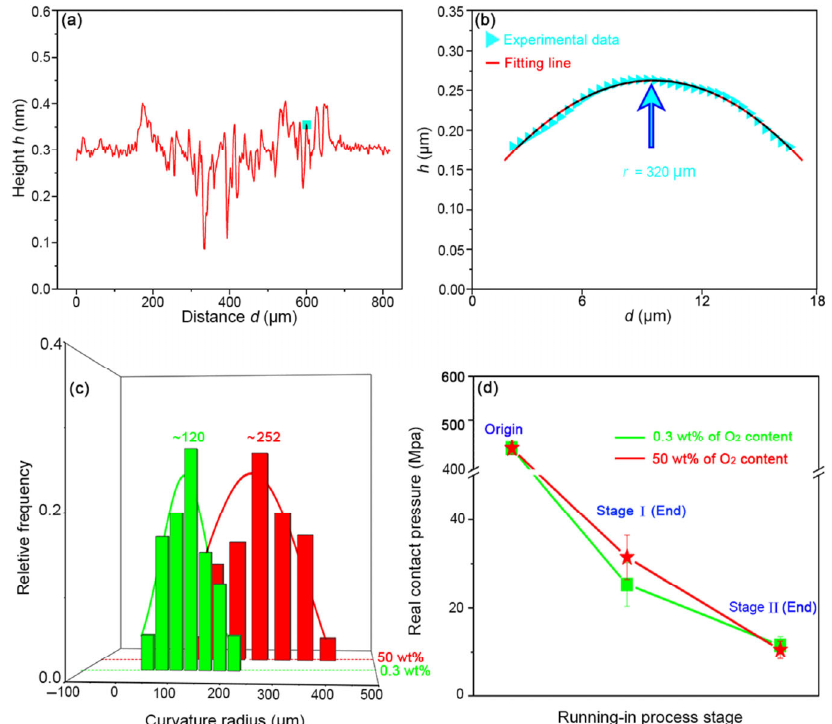
Fig. 5 Evolutions of the real contact pressures during the running-in processes under the two O 2 content environments. (a) Example for a cross-section profile of the wear track on steel substrate formed after Stage II running-in process at 50 wt% O 2 condition. (b) Single asperity inside the wear track (marked by blue) can be fitted circularly with a radius r. (c) Gaussian distributions of the fitted radius of asperities inside the whole wear tracks at the end of Stage II under ~0.3 and ~50 wt% O 2 condition. (d) Decrease of the real contact pressures at different running-in stages under the two O 2 content environments. The error band represents a standard